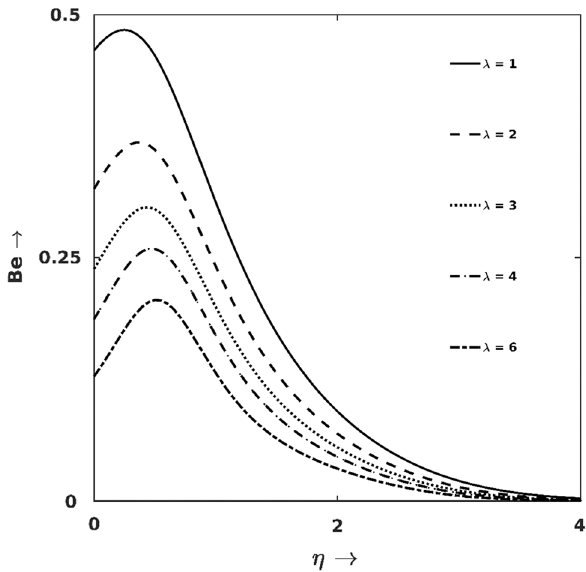
Figure 12. (cid:31) effect on S G